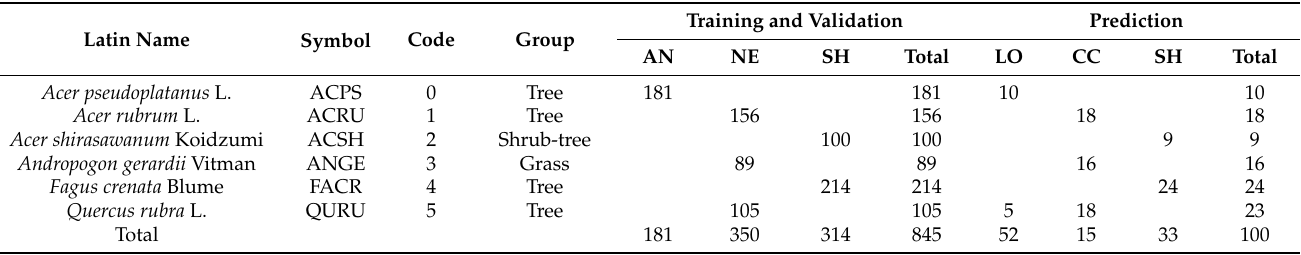
Table 1. Source of training, validation, and prediction datasets (AN = ANGERS, NE = NEON, SH = SHIZUOKA, CC = CCLTER, LO = LOPEX).